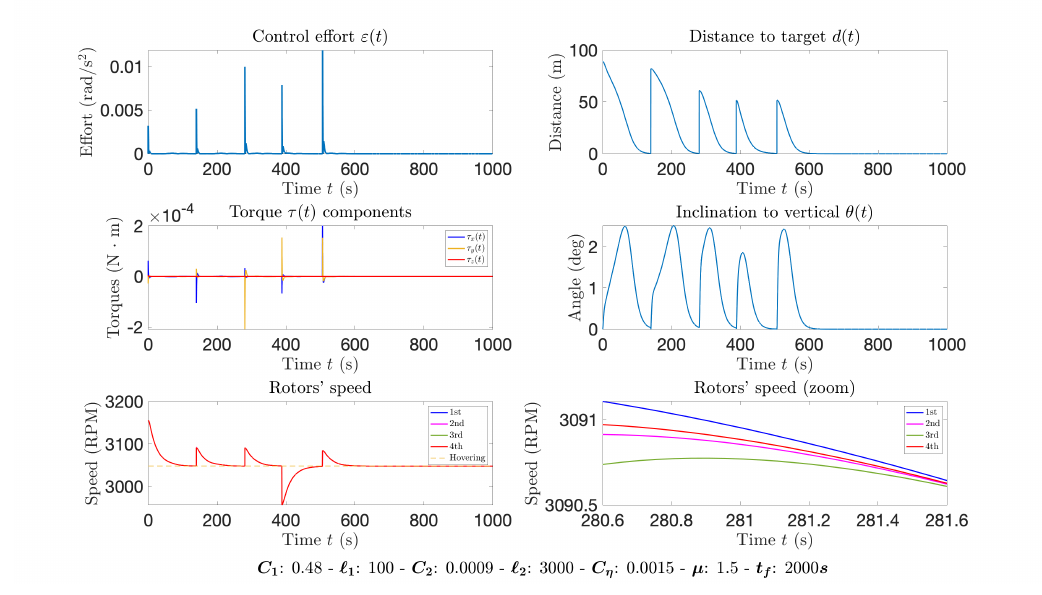
Figure 16. Experiment: Targets shifting randomly in time, second set of VARP parameters. ( a ) Target approaching trajectory; ( b ) Control